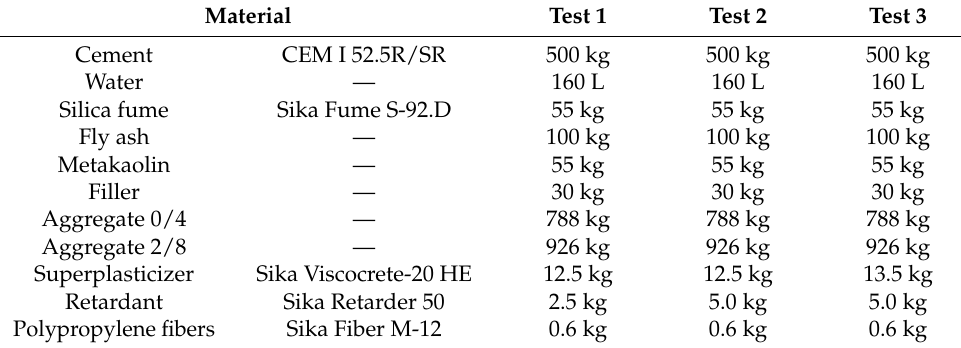
Table 8. Formulation of high-strength self-compacting concrete for lab tests.